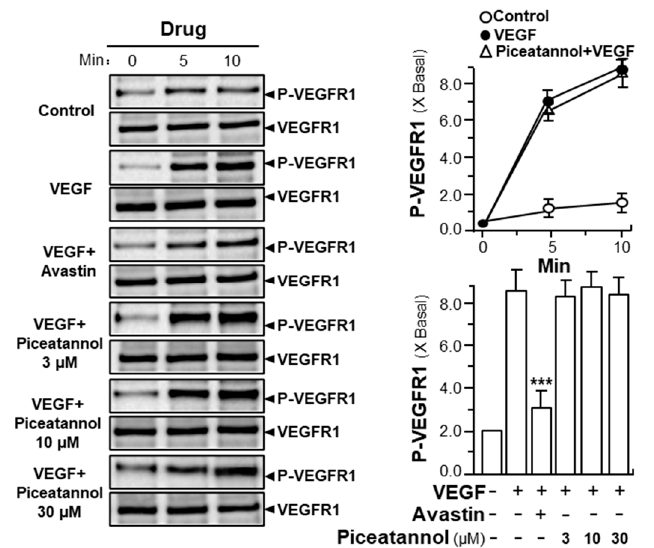
Figure 4. Piceatannol attenuates VEGF-induced VEGFR2 phosphorylation. ( A ) Endothelial cells were seeded into each well of a 12-well plate with cell density set at 2 × 10 5 per well and cells were treated by VEGF (10 ng / mL) with or without piceatannol; ( B ) HUVECs were plated into each well of a 12-well plate with the density set at 2 × 10 5 cells per well. The cells were treated with VEGF (10 ng / mL) with or without piceatannol. An inhibitor for VEGFR2 (SU5416 at 50 µ M) was used. The treatment without SU5416, serving as control, was from values in Figure 4A. After the treatment, cell lysates were collected at di ff erent time points. Expressions of phosphorylated and total VEGFR2 proteins at ~210 kDa and ~230 kDa were determined by western blotting analysis. Avastin (200 µ g / mL) served as a positive control. Data shown as X Basal, where the control group was set as 1, mean ± SEM, where n = 3; p < 0.05 (*); p < 0.01 (**); p < 0.001 (***) vs. VEGF-treated group; p < 0.05 (#); p < 0.01 (##); p < 0.001 (###) vs. its corresponding control, as shown.